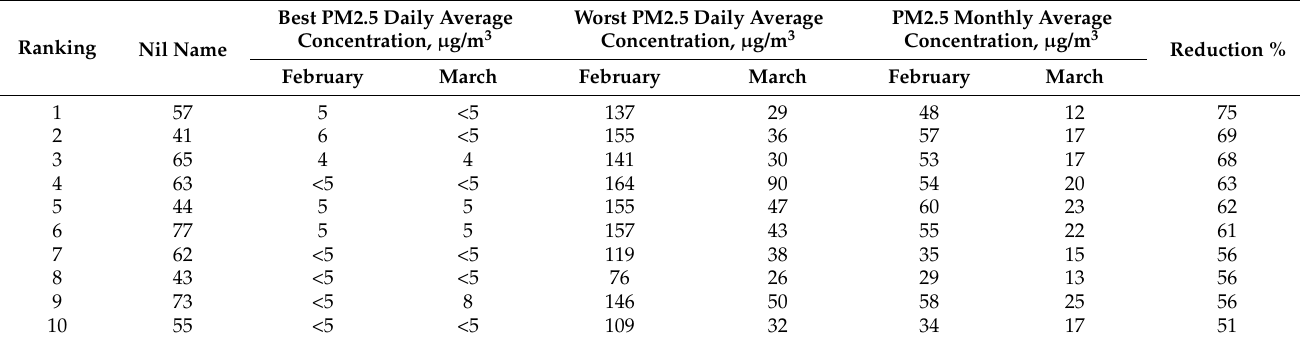
Table 6. Top 10 NILs with the highest PM2.5 reduction rate between March and February.